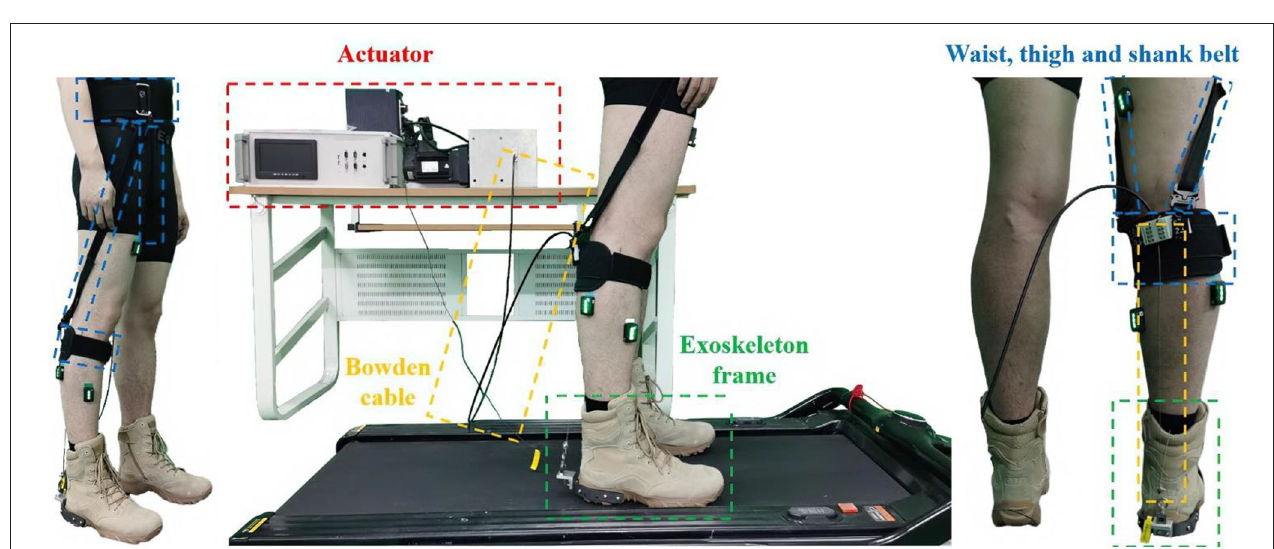
FIGURE 3 | The exoskeleton frame implemented in the second dataset.